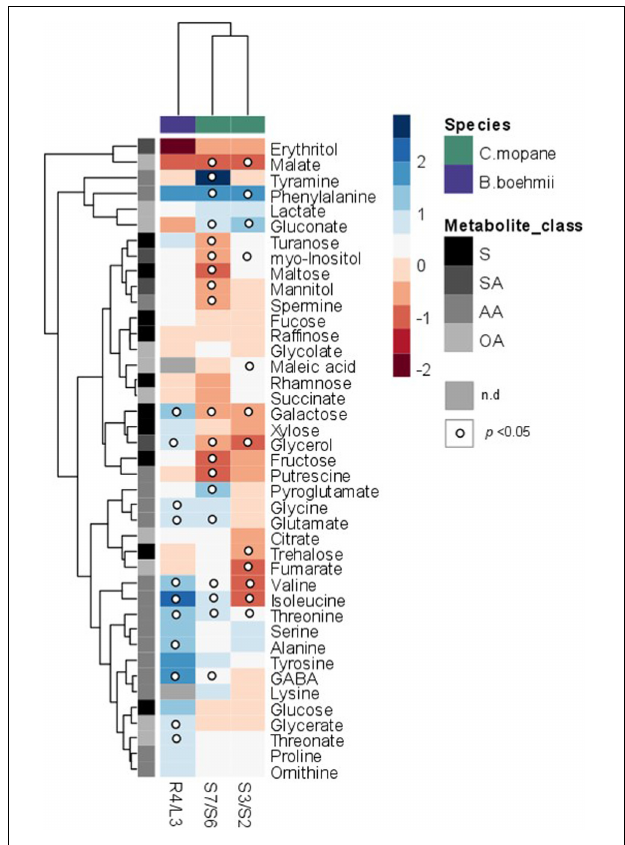
FIGURE 3 | Heatmap showing metabolite responses in C. mopane and B. boehmii under different fire regimes. Metabolites were determined as described in Section “Material and Methods.” Relative values are normalized to the internal standard (ribitol) and dry weight (DW) of the samples. Values presented as means ± SE of three to five independent measurements. Dots indicate that the differences are statistically significant by Student’s t -test ( p < 0.05). Gray-color squares represent not detected (n.d) values. False-color imaging log2-transformed GC-TOF-MS data. AA, amino